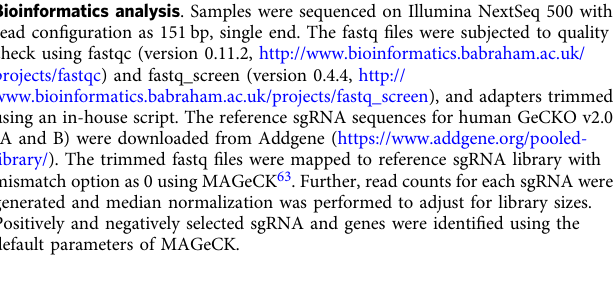
Fig. 7 Ppp1r3g − / − mice are protected from TNF-induced systematic in fl ammatory response syndrome. a Diagram of Ppp1r3g knockout strategy. Positions of sgRNA targeting sites and PCR primers are shown. The majority of the Ppp1r3g coding sequence (CDS) is deleted. b Genomic PCR was performed with PCR-F and PCR-R primers. c RT-PCR was performed for Ppp1r3g and Gapdh from reverse transcription products of liver and ileum mRNA. d MEF cells from WT or knockout mice were treated with DMSO, T/S/Z, T/S, T/CHX, or T/CHX/Z for 16 h followed by CellTiter-Glo assay. Viable cells expressed as a percentage of DMSO-treated cells. Results are represented as mean ± SD of n = 3 biological independent samples. e WT or knockout MEF cells were treated with T/S/Z for various periods. Cell lysates were subjected to Western blotting with the indicated antibodies. p-S321-RIPK1 detects phosphorylated serine 321 of mouse RIPK1 and p-S345-MLKL detects phosphorylated serine 345 of mouse MLKL. f , g WT or knockout mice (8 – 14 weeks old) were injected through tail vein with mouse TNF (0.3 µ g mTNF/g mouse weight). Animal survival ( f ) and body temperature ( g ) were monitored for 48 and 24 h, respectively. Kaplan − Meier survival analysis ( f ) and statistical analysis were performed with GraphPad Prism 8 ( f and g ). **, P < 0.01; ***, P < 0.001. h WT or knockout mice ( n = 4) were injected with PBS or TNF. Serum samples were collected after 4 h and subjected to ELISA assay according to the manufacturer ’ s protocols. i WT or knockout mice ( n = 3) was injected with PBS or mTNF. Organs were harvested after 8 h from survived animals and subjected to H&E staining. Scale bar = 100 µ m. * denotes a necrotic region with vacant space from hepatocyte loss and arrows denote red blood cells without vessels nearby. j Livers were harvested as in ( i ) and protein lysates were subjected to Western blotting with